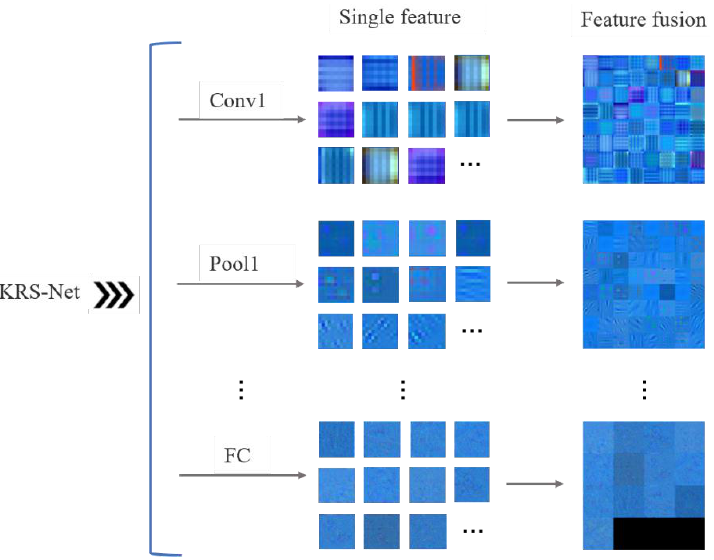
Figure 7. Feature visualization of KRS-Net.